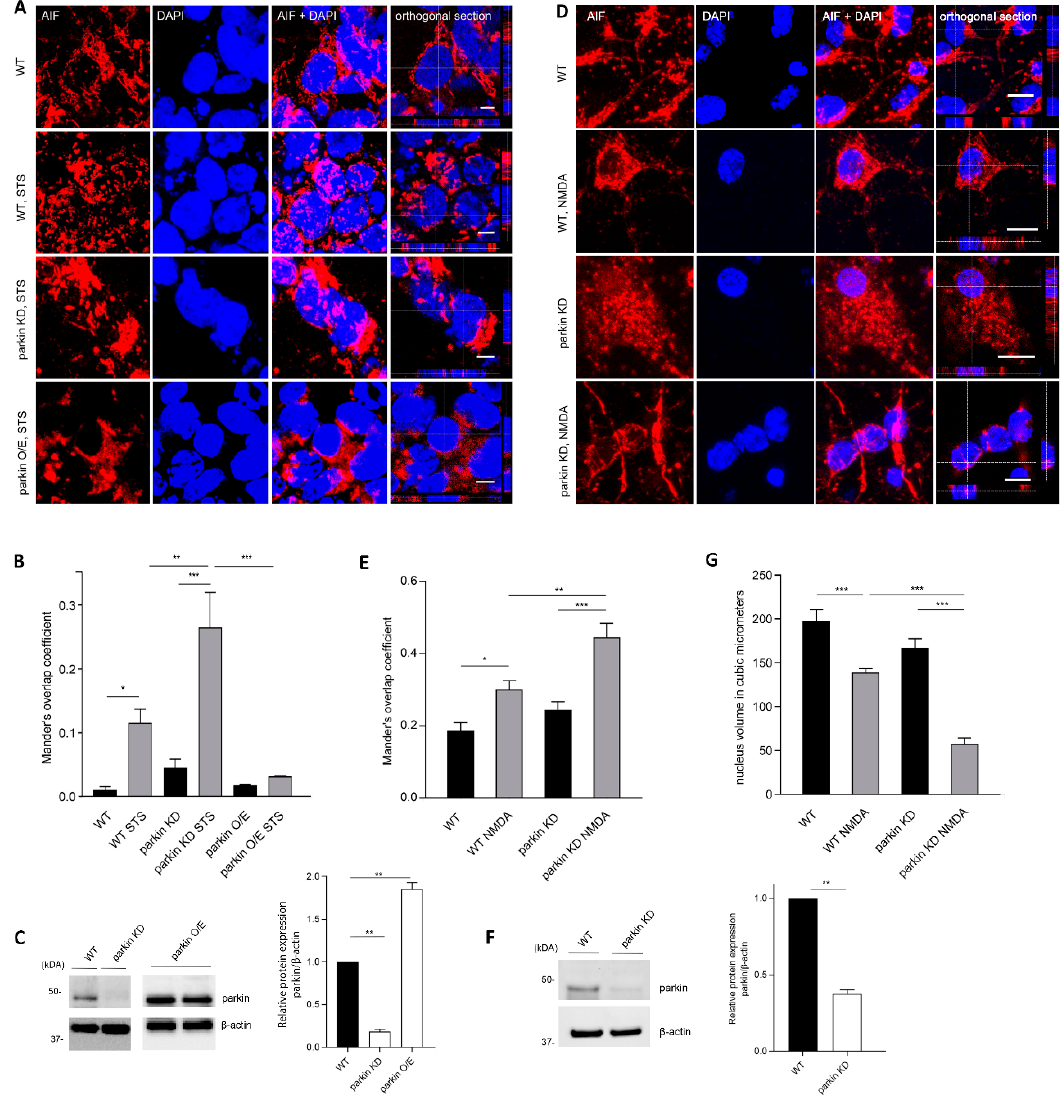
Figure 2. Parkin deficiency increases stress-induced translocation of AIF to the nucleus. ( A ) Representative images of AIF-nuclear colocalization in SH-SY5Y cells (WT, parkin KD, and parkin O/E) after STS treatment (3 h, 2 µ M). Z stacks are provided to demarcate the nucleus. Scale bars: 5 µ m. ( B ) The colocalization was quantified by using the Manders’s overlap coefficient for treated and untreated conditions. ( C ) Whole-cell lysates analyzed by WB show parkin levels for WT, parkin KD, and parkin O/E SH-SY5Y cells. Relative density values were normalized to the loading control β -actin. ( D , E ) Representative images of AIF nuclear translocation and its quantification in primary cortical neurons, WT (control shRNA), and parkin KD, after NMDA treatment (500 µ M plus 10 µ M glycin, 5 min). Scale bars: 10 µ m. ( F ) Whole-cell lysates analyzed by WB show parkin levels in primary neurons, WT (control shRNA) and parkin KD. ( G ) Scoring of nuclear volume average. A lower average is indicative of more pyknotic nuclei present. Statistical differences of Mander’s overlap coefficients, nuclear volumes, and relative protein levels were calculated by one-way ANOVA followed by Tukey’s post hoc test to correct for multiple comparisons. For comparing only two groups a two-tailed Student’s t -test was used. Data are plotted as means ± SEM from three independent experiments (for IF, randomly chosen areas of at least two wells per condition). * p ≤ 0.05, ** p ≤ 0.01, *** p ≤